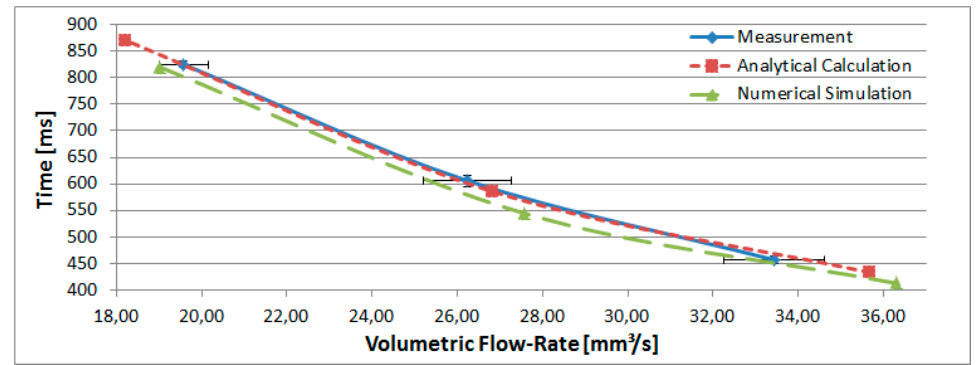
Figure 4. This figure shows the time between two successive droplets depending on the volumetric flow rate into the droplet: The time increases with decreasing volumetric flow